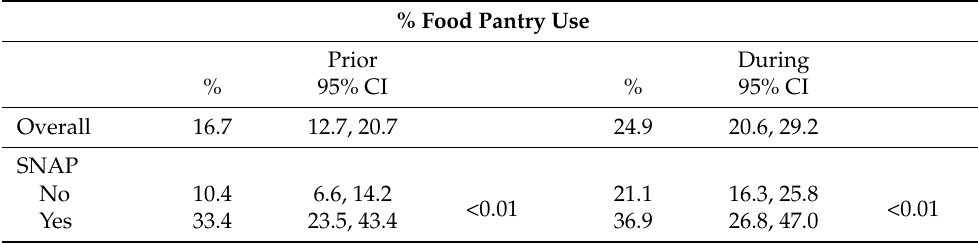
Table 3. Adjusted prevalence of food pantry use among households with children by federal food assistance program participation status prior to and during the first four months of the